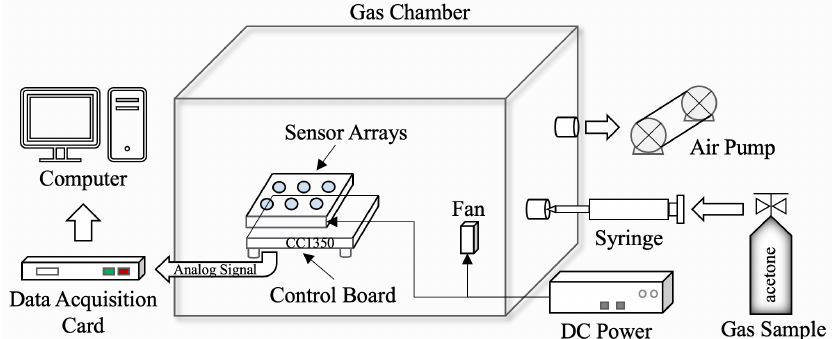
Figure 6. Block diagram of Self-Detection and Self-Calibration experimental platform.